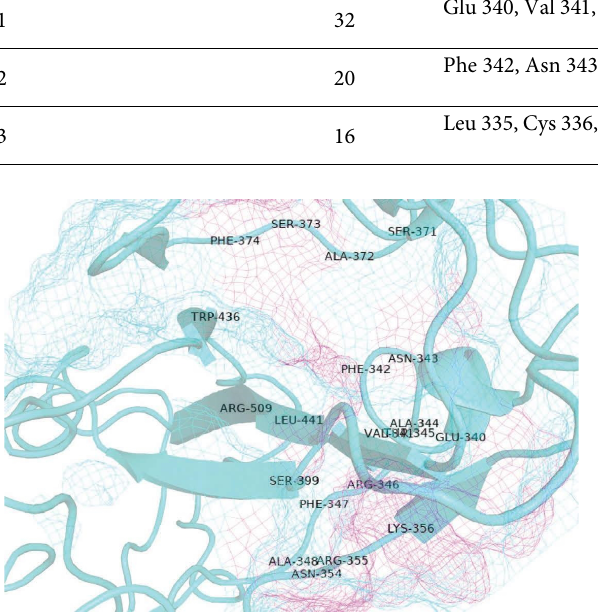
Figure 2: Te binding pocket of spike protein along with binding